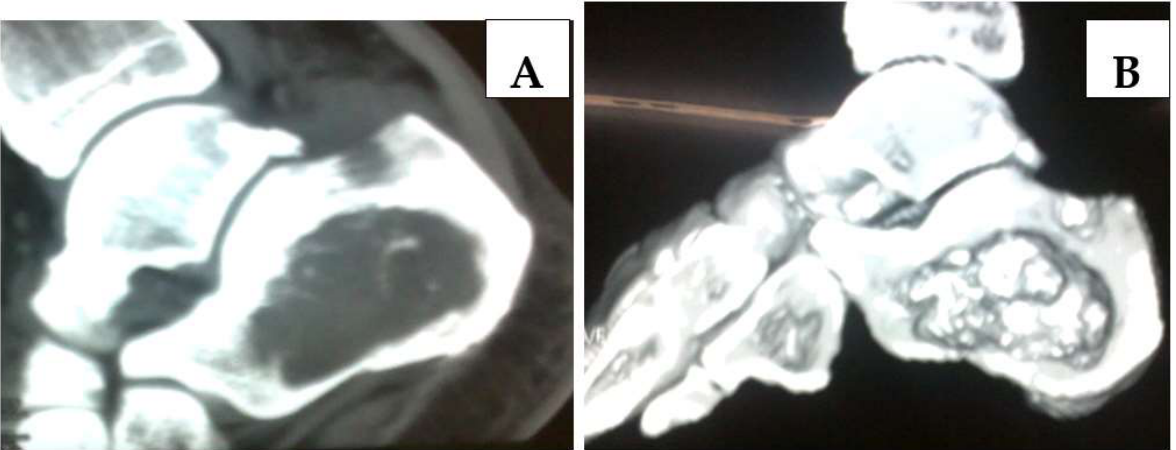
Figure 2. MSCT ( A ) with 3D reconstruction ( B ) revealed hypodense focuses of osteonecrosis and bone marrow edema in the left calcaneus. Intraarticular and soft-tissue edema were also noted. Percutaneous needle aspiration of the periarticular soft tissue was performed and a very small amount of the fluid was aspirated. Biochemical analysis showed elevated amylase (548 U/L), and lipase (1300 U/L) levels. There were not any signs of inflamma- tory exudate (white blood cells count, sugar, proteins, CRP, and interleukin-6were within the limits). Bacterial cultures were negative. An Orthopedic surgeon performed calcaneal curettage and mini-incisional drainage of subcutaneous lesions. Histopatho- logical examination showed necrotic fat and connective tissue with moderate lympho- cytes infiltration.